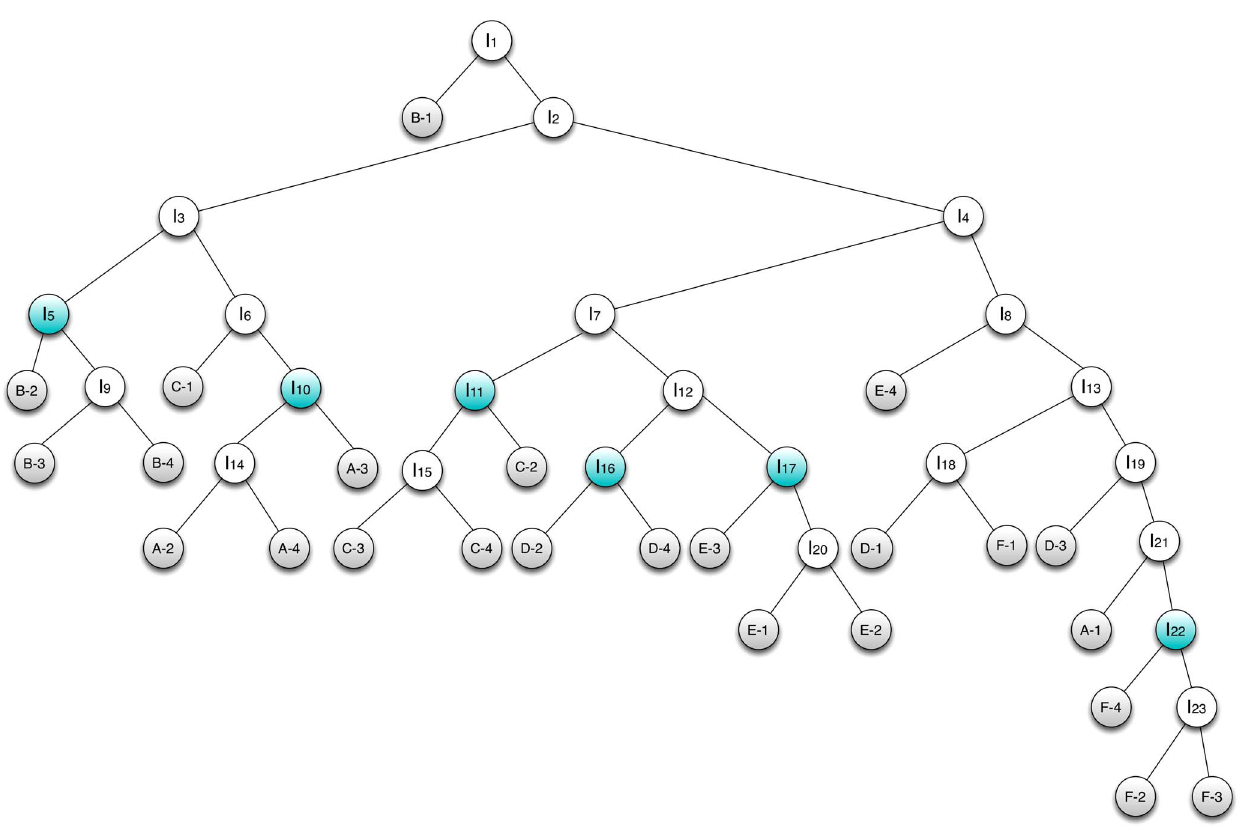
Figure 2. Binary tree representation of the dendrogram shown in Figure 1. Leaf nodes are shaded in grey and are labeled according to the subject and time point as in Figure 1. Internal nodes are labeled I 1 through I 23 , and those internal nodes I i for which f ( i , j ) is maximized for some group G j (where G 1 corresponds to subject A, G 2 corresponds to subject B, and so on; see also Equation 1) are shaded in blue.